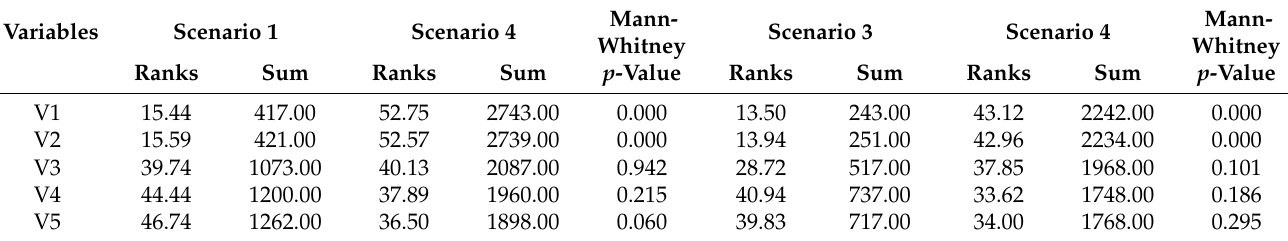
Table 2. Mann-Whitney U test: differences in ranks between relevant scenarios.